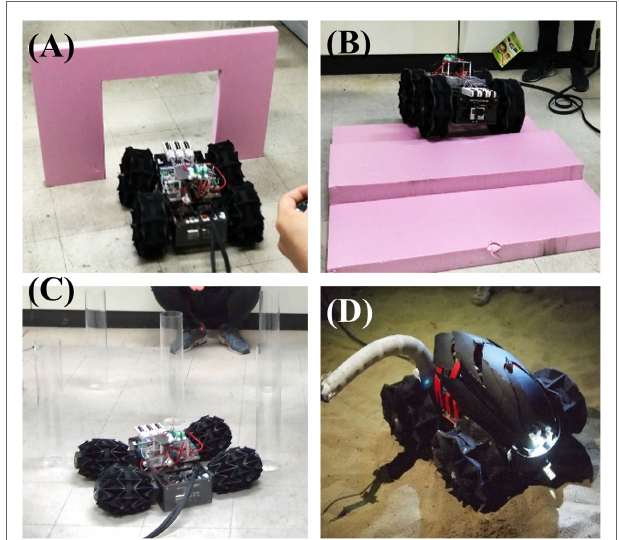
FigUre 10 | sandbox testing of the prototype robot . (a) Passing through an aperture. (B) Climbing stairs. (c) Passing between unstable obstacles. (D) Sandbox test of the final challenge-ready